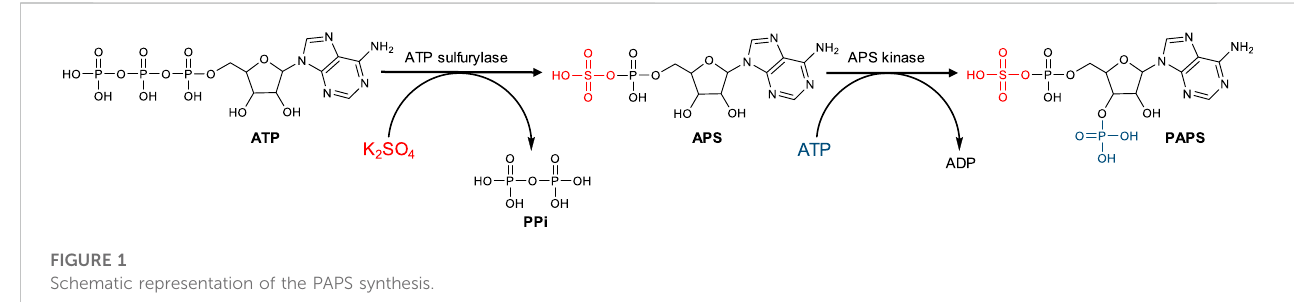
FIGURE 1 Schematic representation of the PAPS